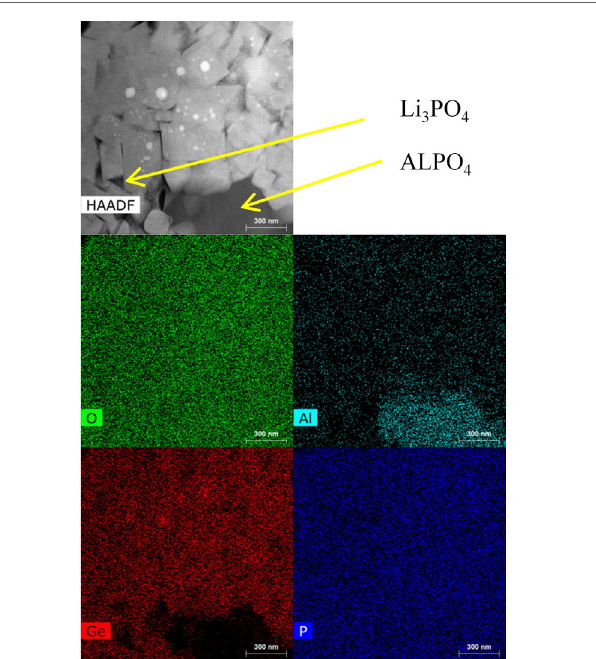
FigUre 9 | hrTeM, eDs elemental maps, conventionally sintered sample .